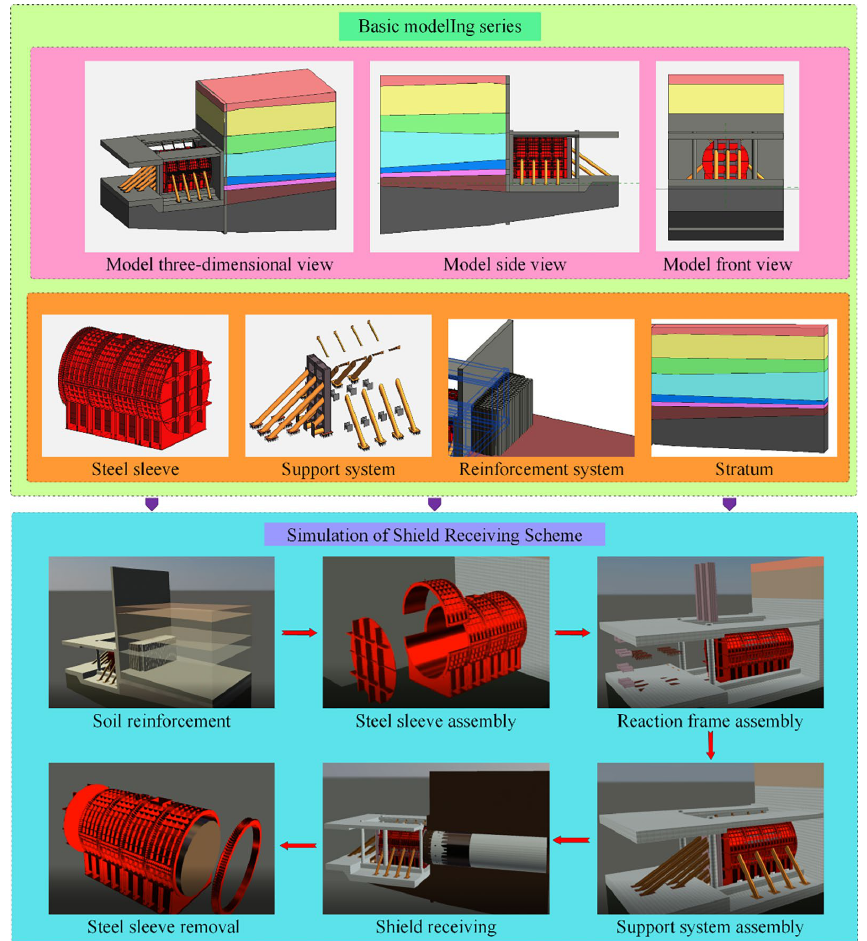
Figure 7. Simulation of shield receiving scheme for Tianjin Metro Line